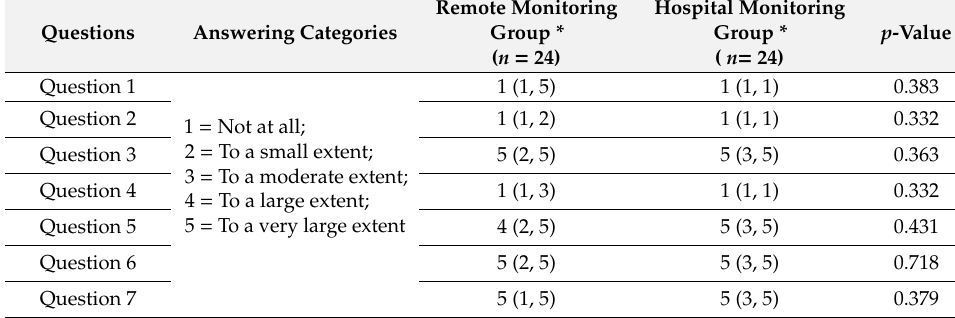
Table 5. Results derived from the adapted version of the Health Care Communication Questionnaire (HCCQ).